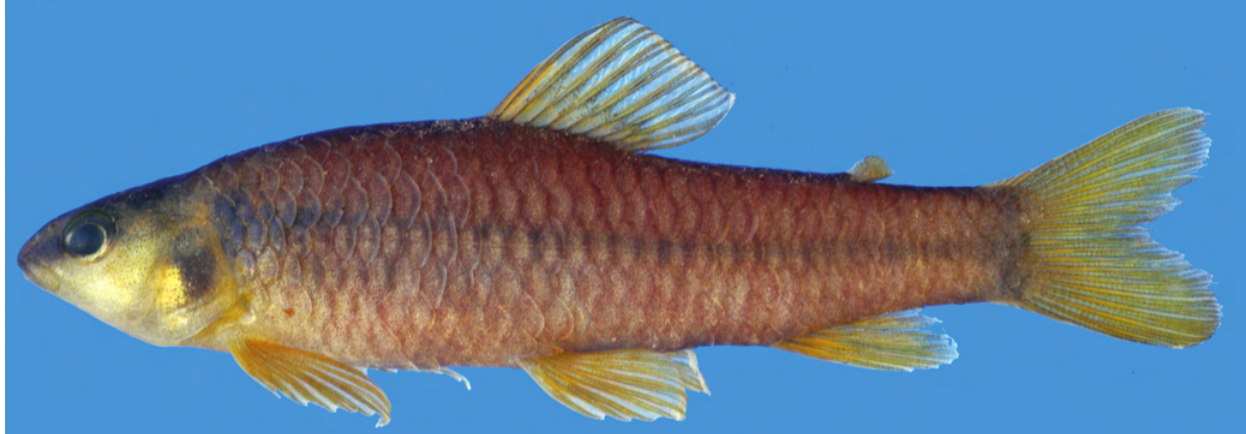
Fig. 1. Characidium xanthopterum , holotype, DZSJRP 10474, 47.3 mm SL, freshly preserved